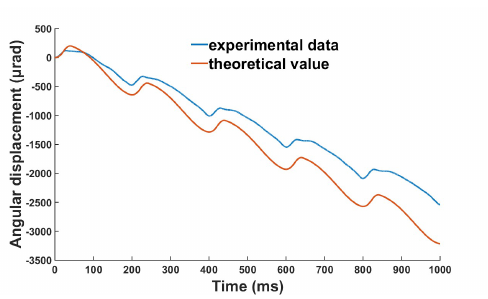
Figure 11. Comparison of theoretical results and experimental results at a voltage of 300 V and frequency of 5